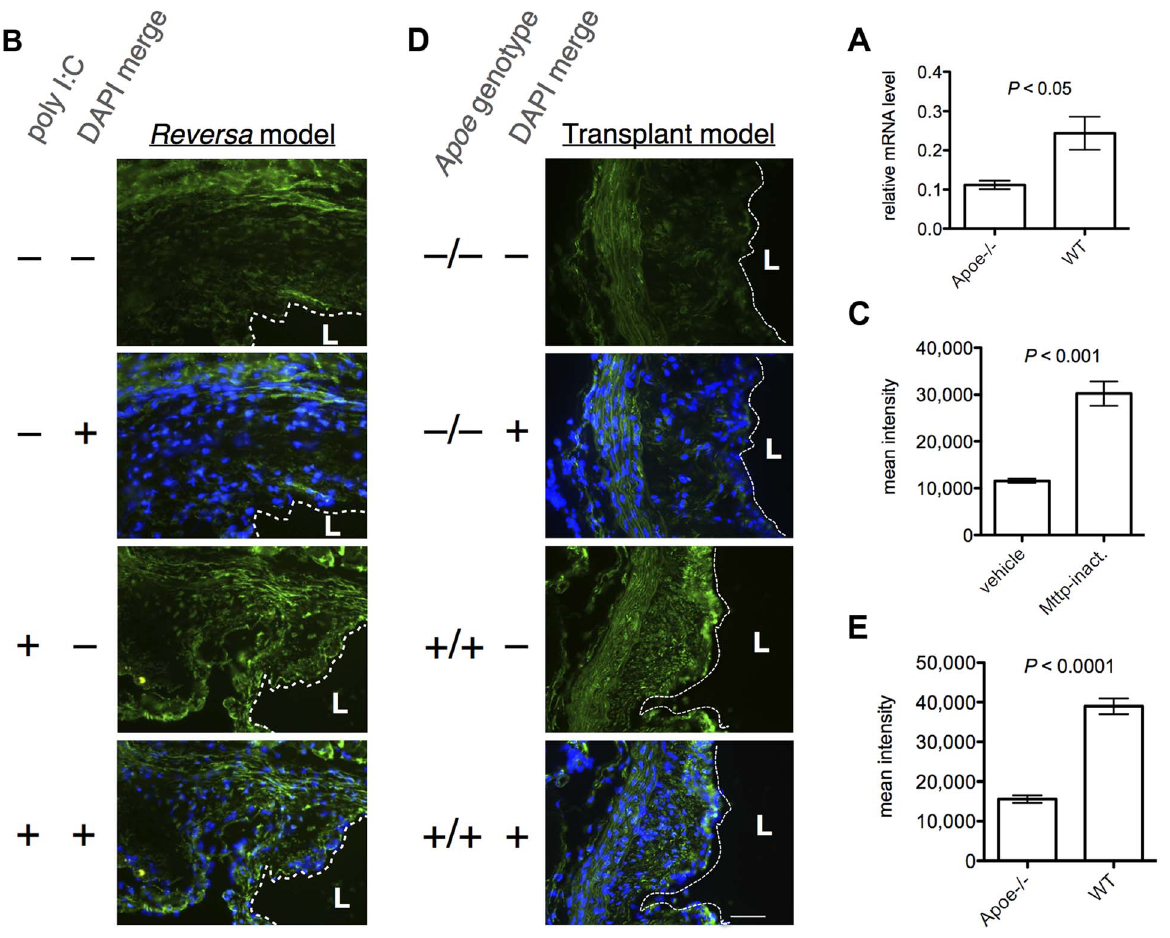
Figure 5. b -catenin expression is increased in regressing vs. progressing plaques, in both models of plaque regression. (A) The relative Ctnnb1 ( b -catenin mRNA) levels, as measured by qPCR, are higher in CD68 + cells in regressing plaques than in progressing plaques, in the aortic transplant model (day five post-transplant) . Bars, mean 6 SE ( N =6 animals per sample group). (B, C) Plaques in Mttp-inactivated Reversa mice have higher levels of b -catenin than plaques in vehicle-treated animals . (B) Representative fluorescence micrographs from an immunohistochemical analysis of b -catenin expression at the aortic root in the Reversa mouse at day seven post-injection to inactivate Mttp ( N =3 animals per group, six sections analyzed per animal). Green, b -catenin immunofluorescence; blue, diamidino-2-phenylindole (DAPI) fluorescence; dashed white line divides lumen (‘‘L’’) from intima; scale bar, 50 m m. The green signal in the upper part of the top panel is autofluorescence from the elastic lamina. (C) Plaque b - catenin expression for each treatment group was quantified by morphometric image analysis. Bars, mean 6 SE ( N =4 per treatment group); ‘‘Mttp- inact.’’, Mttp -inactivated. (D, E) Plaques in WT recipient animals have higher levels of b -catenin than do plaques in Apoe 2 / 2 recipients, in the transplant regression model . (D) Representative fluorescence micrographs from an immunohistochemical analysis of b -catenin expression in the aortic transplant model ( N =3 animals in each genotype group, six sections per graft), at day five post-transplant. Color channels and annotations are as for (B). (E) Plaque b -catenin expression for each genotype group, by morphometric analysis. Bars, mean 6 SE ( N =4 per genotype group). P values in (A,C,E) are from unpaired, two-tailed, Student’s t -tests.